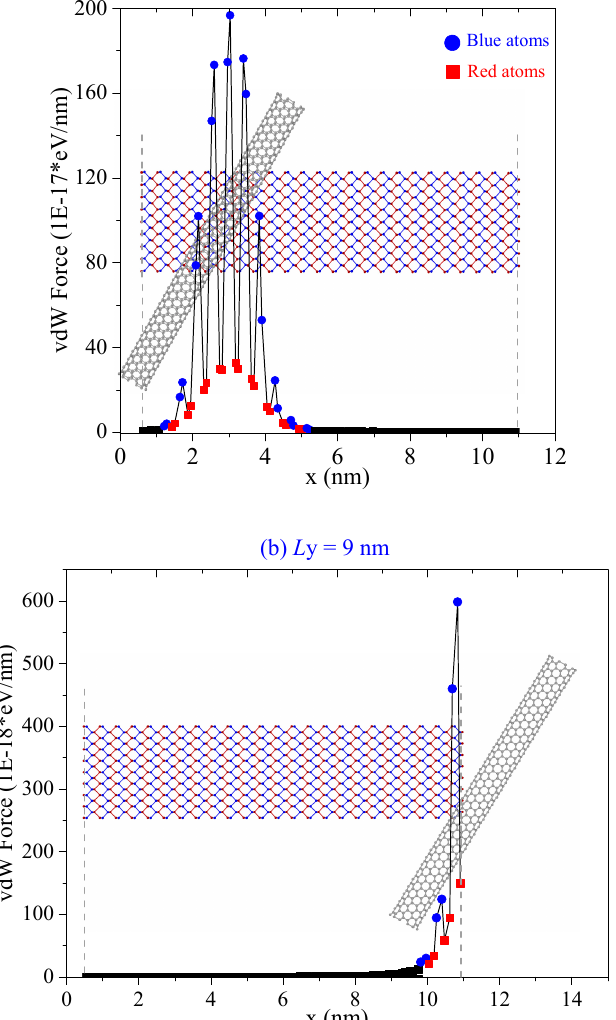
Figure 4. Resultant van der Waals force of the CNT (10, 10) on each column of phosphorus atoms in the BP ribbon with α = − 30°. (a) L y = 0 nm. (b) L y = 9 nm.